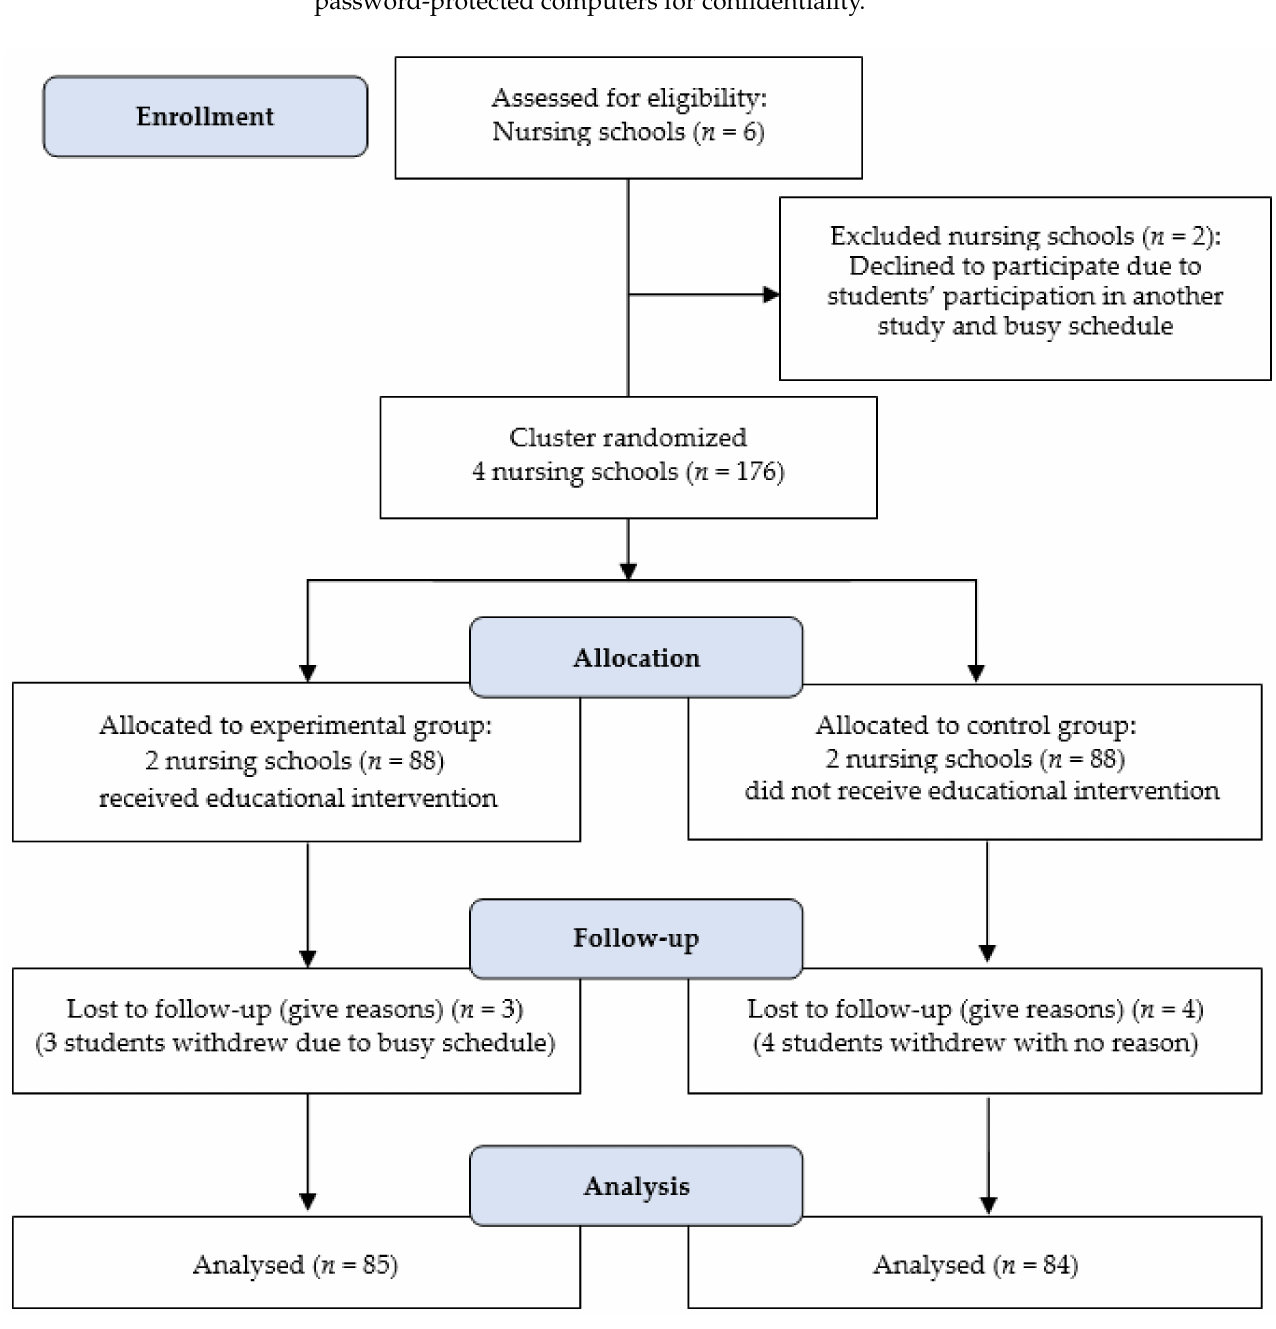
Figure 1. A flow diagram of participant recruitment and retention throughout the